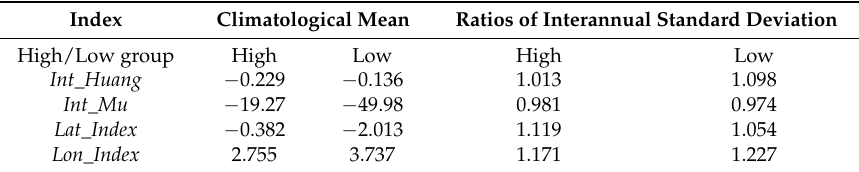
Figure 12. ( a , b ) Climatological mean of the geopotential height at 500 hPa and ( c , d ) its interannual standard deviation composited in ( a , c ) high and ( b , d ) low resolution CMIP5 models. The contours indicate their differences with respect to observations. The red (green) lines represent the trough line in the observations (high/low-resolution CMIP5 models). Table 3. Composited differences of EAT characteristic indices and the ratios of interannual standard deviation in high- and low-resolution models.